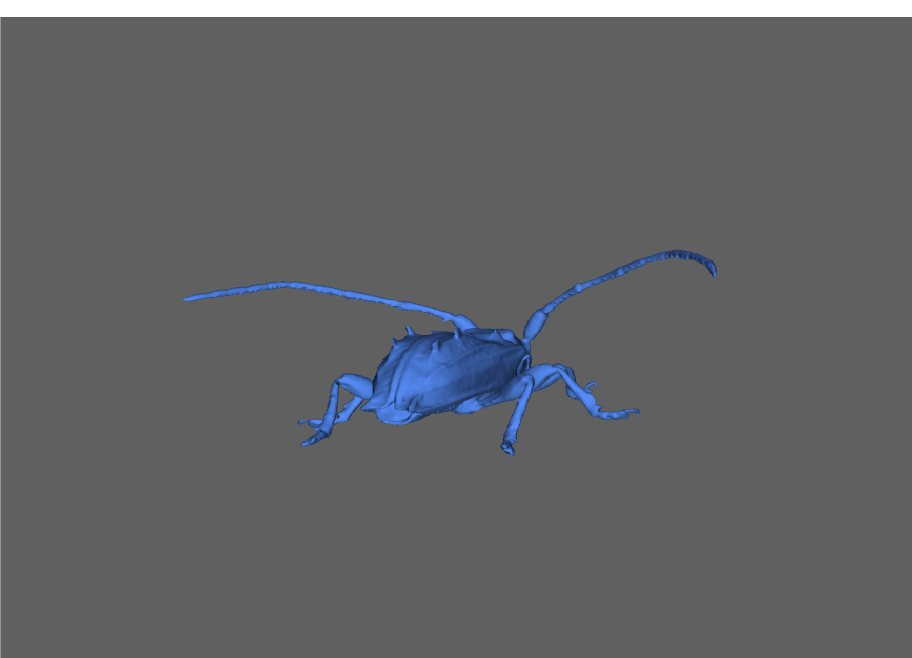
Figure 14. Interactive 3D-model of Pogonocherus hispidus (6 mm body size).